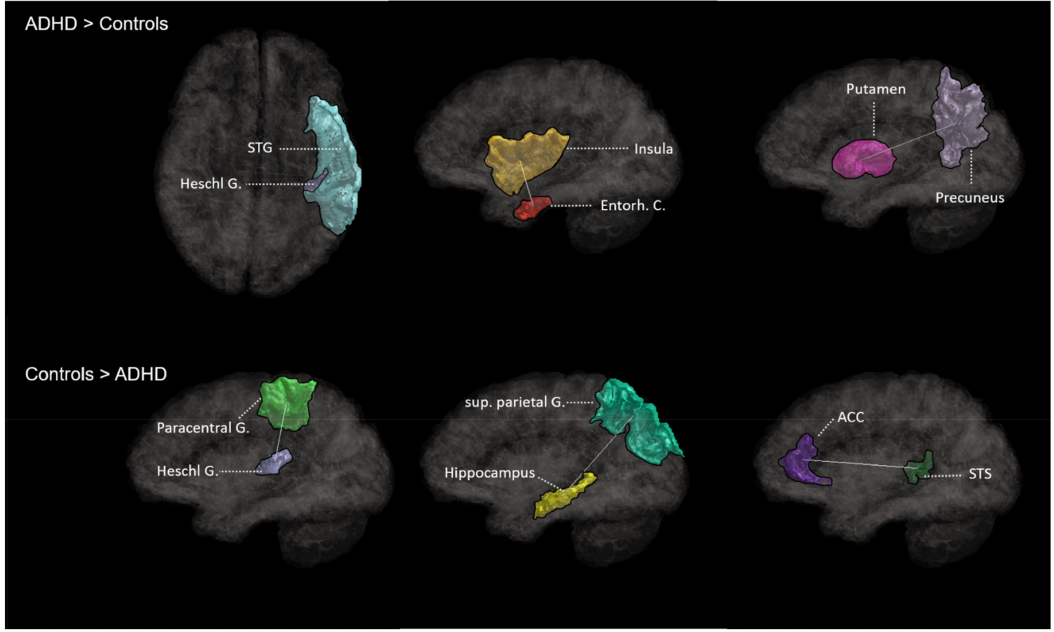
Figure 2. Hyper- ( top ) and hypo- ( bottom ) network connectivity of patients with ADHD compared to healthy controls. Abbreviations: STG, superior temporal gyrus; G, gyrus; Entorh. C., entorhinal cortex; sup. parietal G., superior parietal gyrus; ACC, anterior cingulate cortex; STS, superior temporal